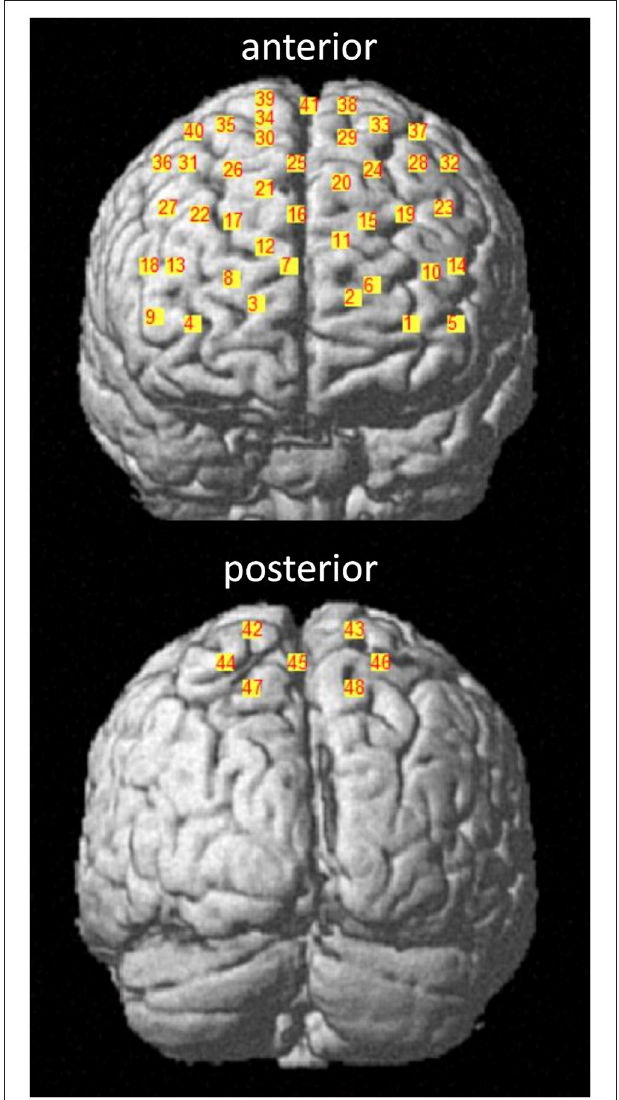
FIGURE 3 | fNIRS channel locations. Channels are displayed in the anterior and posterior plane with corresponding channel numbers for a representative participant. The 10–20 EEG system was used as a reference. Channel 41 corresponds to the Cz